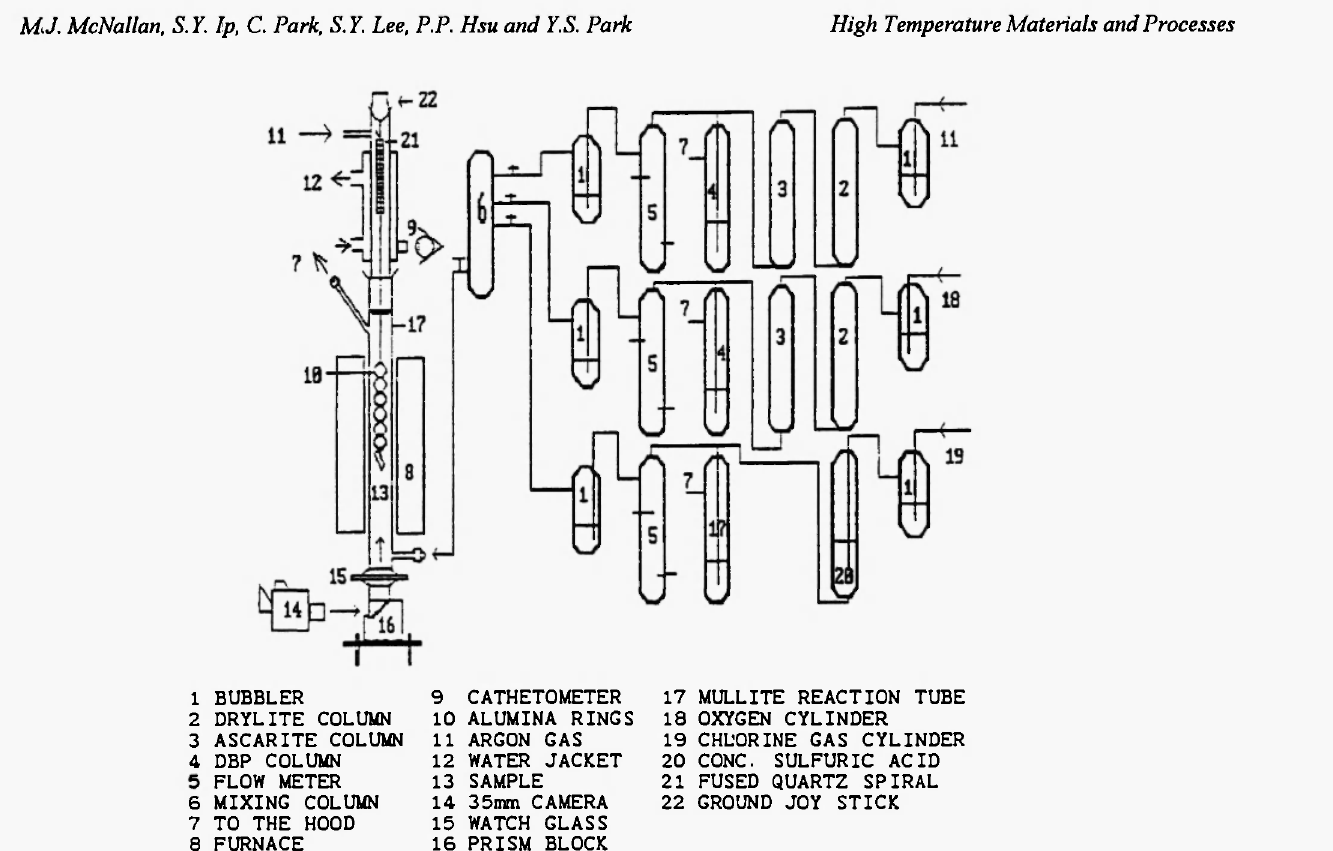
Fig. 1: Schematic diagram of apparatus used for thermogravimetric